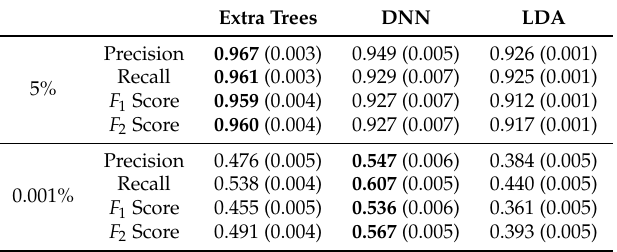
Table 6. Performance metrics mean (and standard deviation) for the high-performing classifiers, comparing sample sizes of 5% and 0.001%. Higher values (better) are displayed in